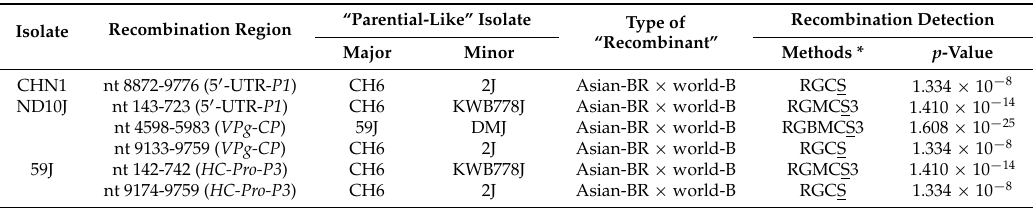
Table 4. Recombination sites and possible parent-like isolates.